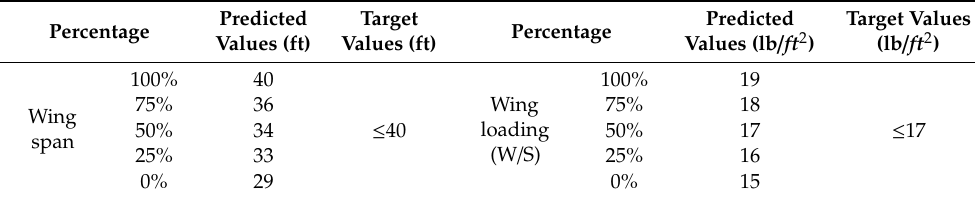
Table 6. Target design variable values 2 for a roadable PAV.